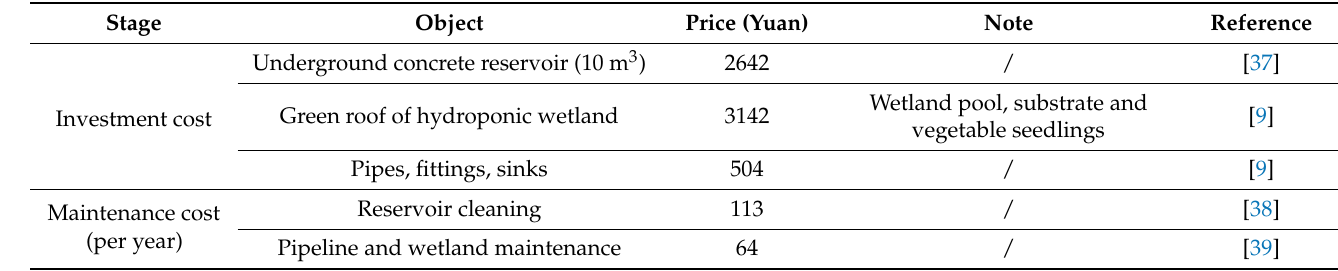
Table 3. Estimation of investment and economic benefit of the PBT-GR